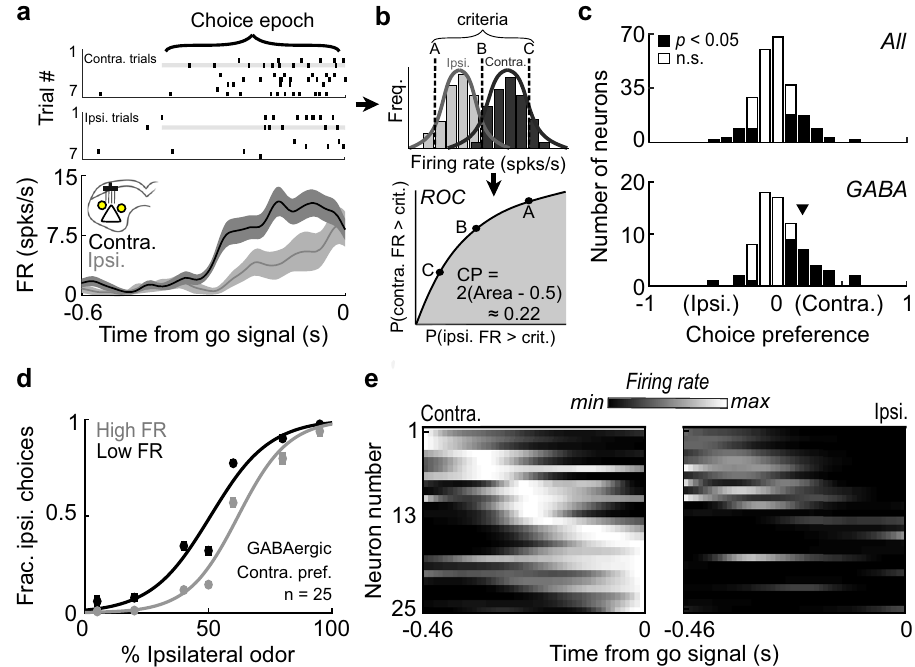
Fig. 4 Endogenous activity of GABAergic SC neurons corresponds to contralateral choices. a Rasters and peri-event histograms for an identi fi ed GABAergic neuron recorded in a behavior/recording session aligned to go signal and segregated by choice direction. Rasters show seven randomly selected trials per group. Shading, ±SEM. b Calculation of choice preference for neurons recorded in behavior/recording sessions. Distributions of trial-by- trial choice-epoch fi ring rates are calculated across ipsilateral and contralateral choices, from which an ROC curve is constructed by computing the fraction of trials, separately for ipsilateral and contralateral choices, with higher fi ring rates than a shifted criterion (e.g., A, B, C). Choice preference ranges from − 1 (strongest ipsilateral preference) to 1 (strongest contralateral preference). c Choice preferences for all neurons and for GABAergic neurons only. Black, neurons with signi fi cant choice preference ( p < 0.05). All neurons: 49 prefer contra., 23 prefer ipsi., p = 0.0022, Χ 2 test; GABAergic neurons: 25 prefer contra., 4 prefer ipsi., p = 9.7 × 10 − 5 , Χ 2 test. Arrowhead, example neuron in ( a ). d Conditional psychometric functions constructed separately for trials in which endogenous choice-epoch fi ring rate was high (top quartile) or low (bottom quartile) for GABAergic neurons with a signi fi cant contralateral choice preference (right black bars at bottom of ( c )). e Normalized activity during the choice epoch of each contralateral-preferring GABAergic neuron (right black bars at bottom of ( c )), separated by choice on each trial. Neurons are sorted by time of maximum fi ring rate for contralateral choices.